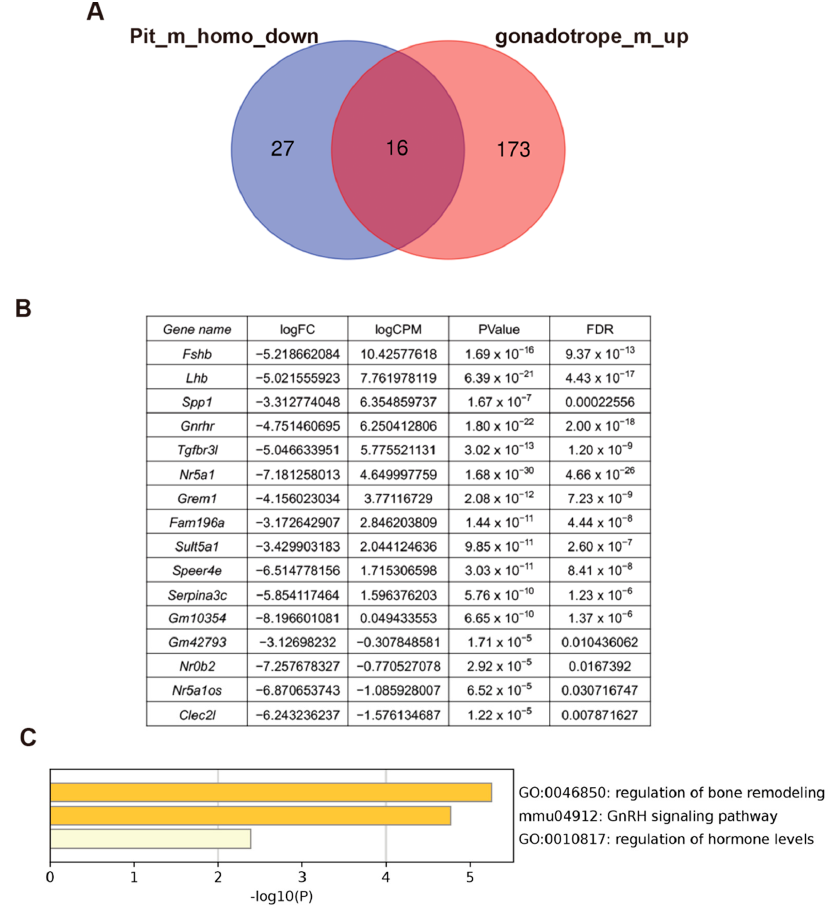
Figure 8. Transcriptomic analyses of the whole pituitary gland and isolated gonadotropes in males. ( A ) Venn diagram showing an overlap between genes downregulated in PE − / − pituitary (Pit_m_homo_down) relative to the control and those showing higher expression in the gonadotropes than in the whole pituitary (gonadotrope_m_up). ( B ) List of the 16 overlapping genes of the two gene sets shown in ( A ); differential expression of 16 genes between control and PE − / − pituitary glands. ( C ) GO terms enriched in the 16